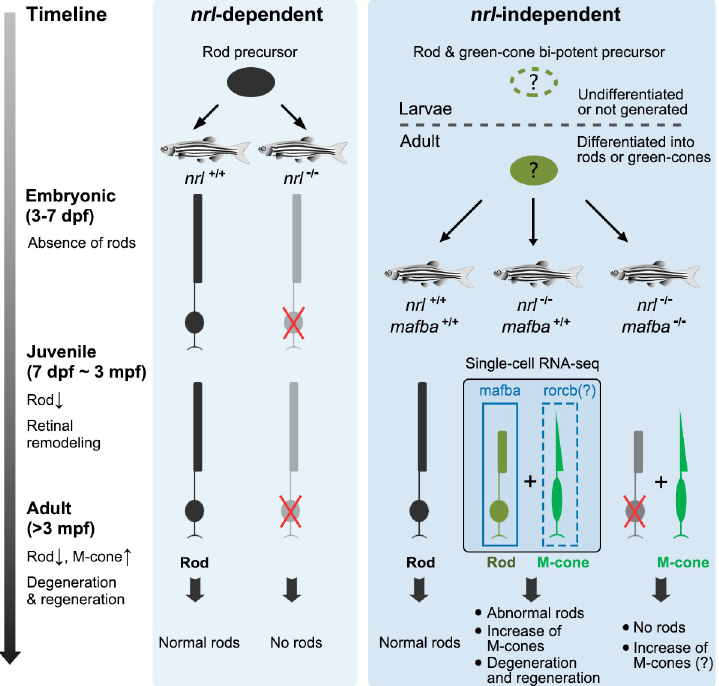
Fig 11. Working model for the development of rod photoreceptors in the zebrafish. There may be two types of rod precursors defined as nrl -dependent and nrl -independent in the zebrafish retinas. The former is responsible for the production of rods at embryonic stage, and knocking out nrl abolishes the differentiation into rods (left panel). The latter is responsible for the production of rods at the juvenile and adult stages. In the presence of nrl and mafba , these cells differentiate into rods. Knocking out nrl does not severely affect the production of rods from these cells but causes abnormal expression of rod- and cone-specific genes and a progressive increase of green cones (M-cones) with age. Knocking out both nrl and mafba eliminates all rods, suggesting that mafba also plays an important role in the fate determination of this type of rods (right panel).